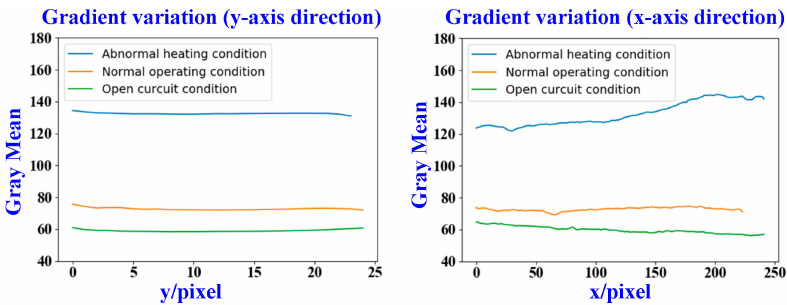
Figure 13. Gradient variation in different